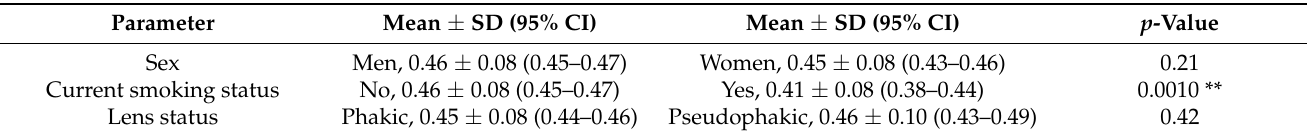
Table 6. Possible association among AGEs score (A.U.) and various categorical parameters.